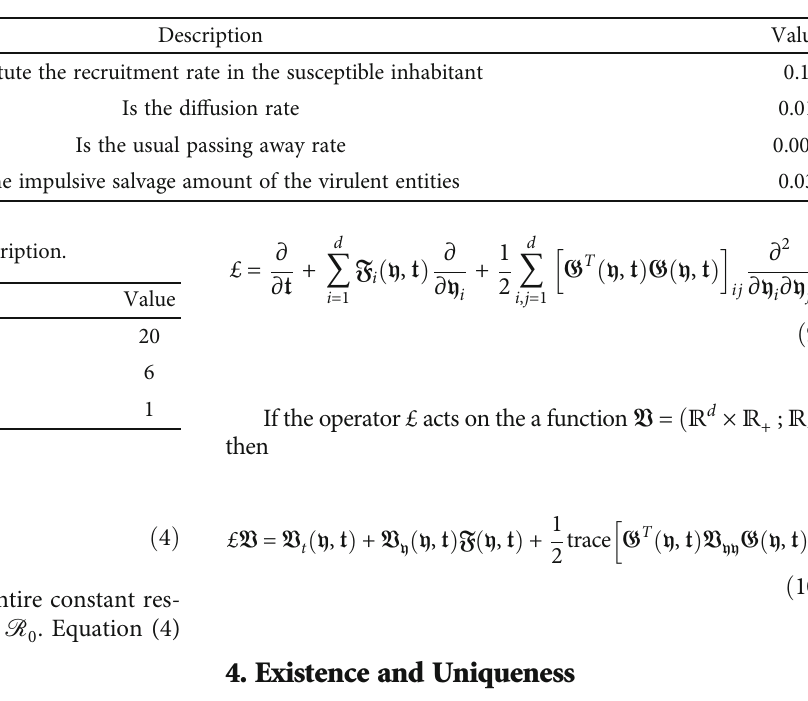
Table 1: Parametric description of the model.